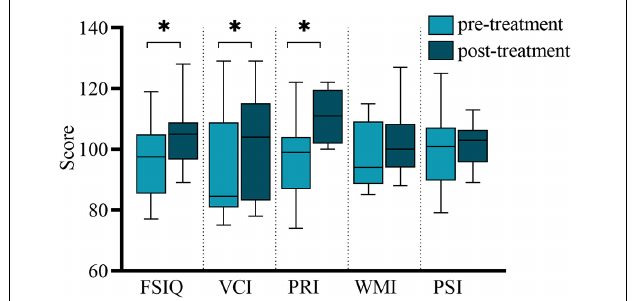
FIGURE 1 | Comparison of WISC-IV scores before and after treatment. FSIQ, Full-scale Intelligence Quotient; VCI, verbal comprehension index; PRI, perceptual reasoning index; WMI, working memory index; PSI, processing speed index. ∗ The p -value was statistically significant.